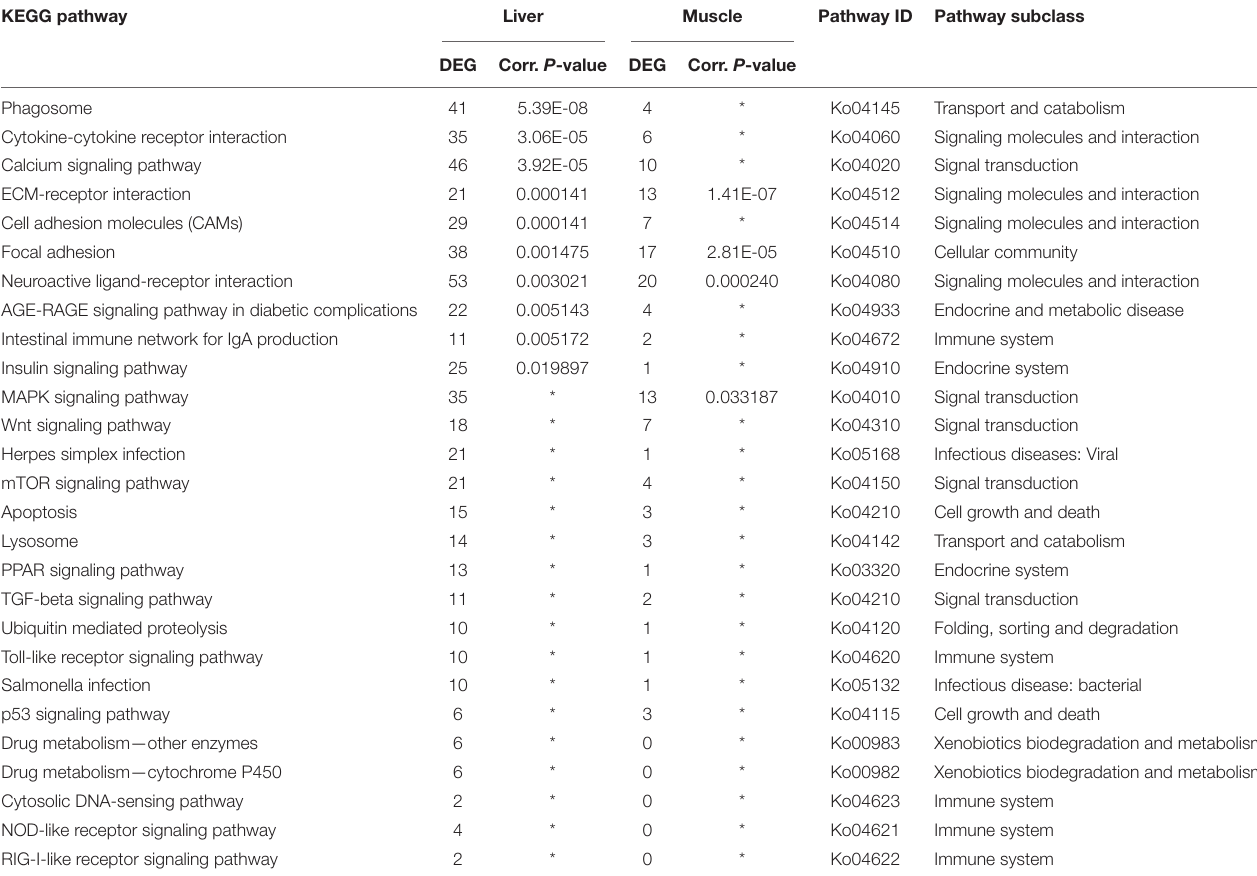
TABLE 4 | Distribution of the differentially expressed genes in immune-relevant pathways in sick (vs. healthy) barramundi. KEGG pathway Liver Muscle Pathway ID Pathway subclass DEG Corr. P -value DEG Corr. P